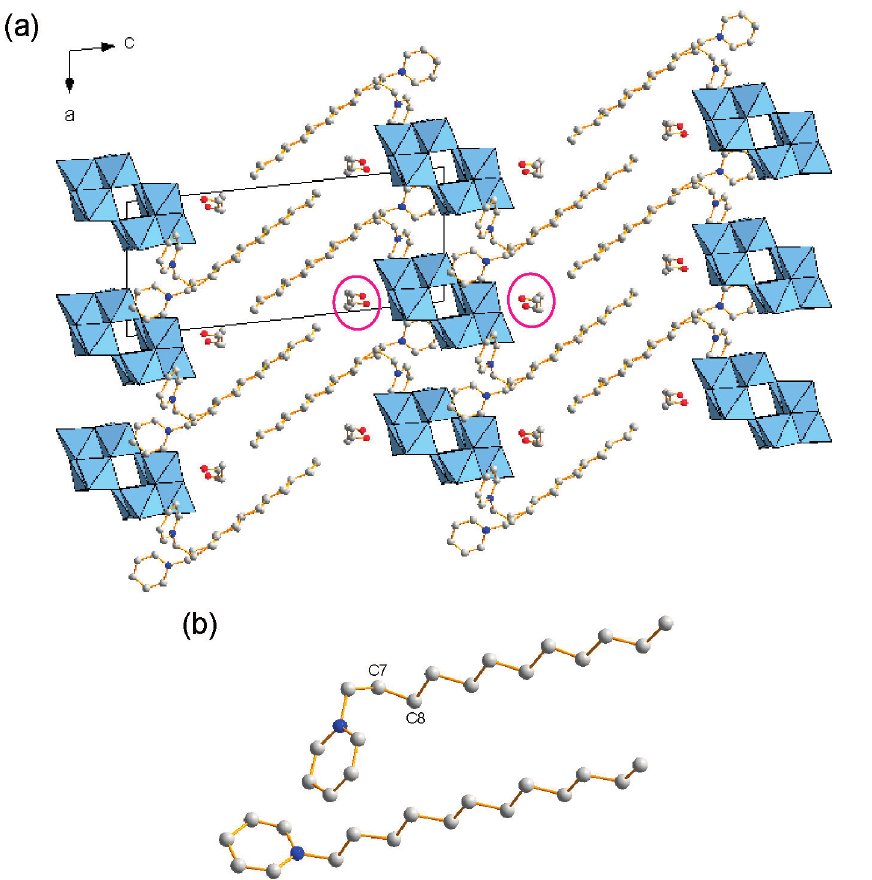
Figure 4. Crystal structure of 2 (C: gray, N: blue; W 10 anions in polyhedral representations. H atoms are omitted for clarity). ( a ) Packing diagram along the b axis. Some ethanol molecules are highlighted; ( b ) View of crystallographically-independent surfactant molecules in 2